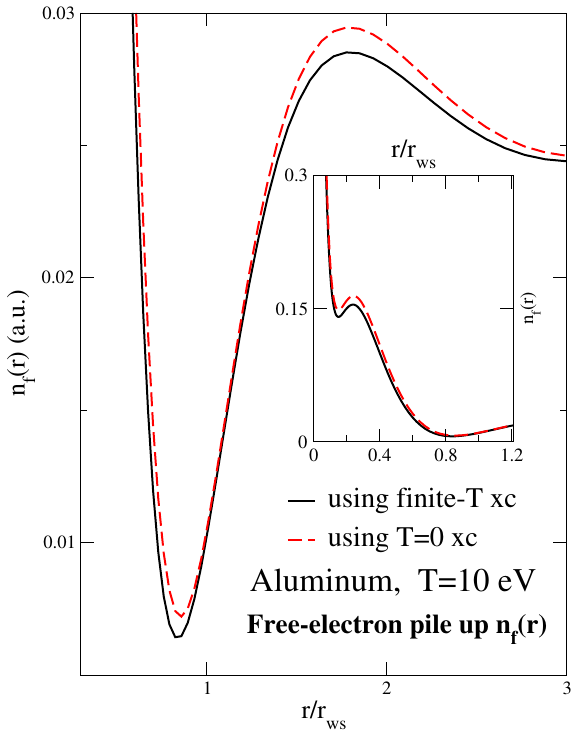
Figure 2. (Color online) The NPA free-electron density n f ( r ) using PDW finite- T XC and with the T = 0 XC. Inset: n f ( r ) inside the Wigner-Seitz sphere, with r ws (cid:39) 3.0